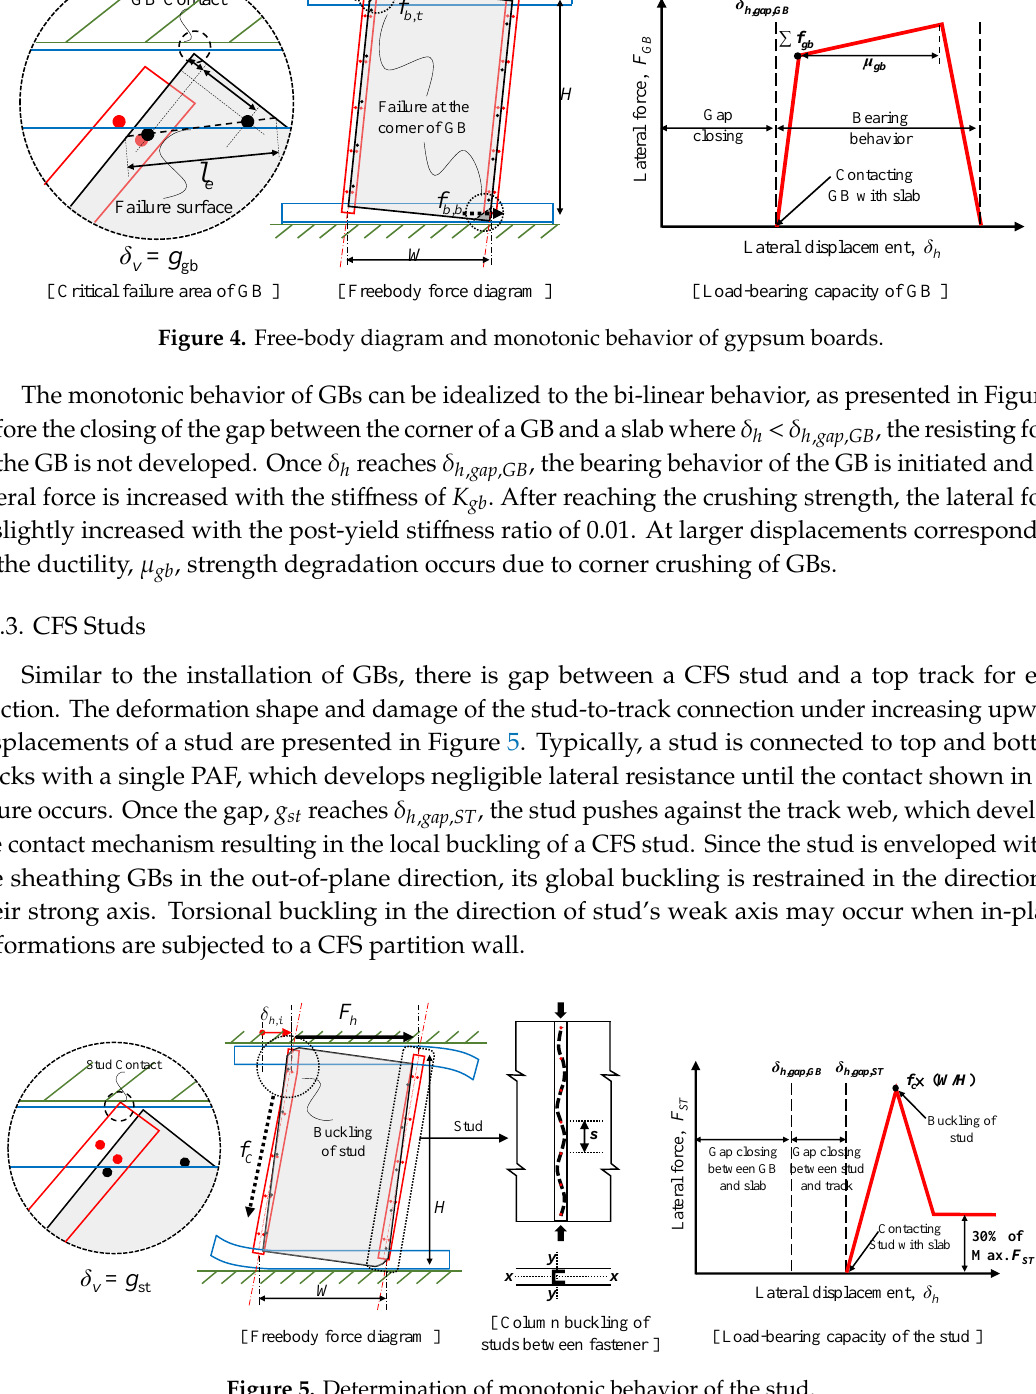
Figure 5. Determination of monotonic behavior of the stud.